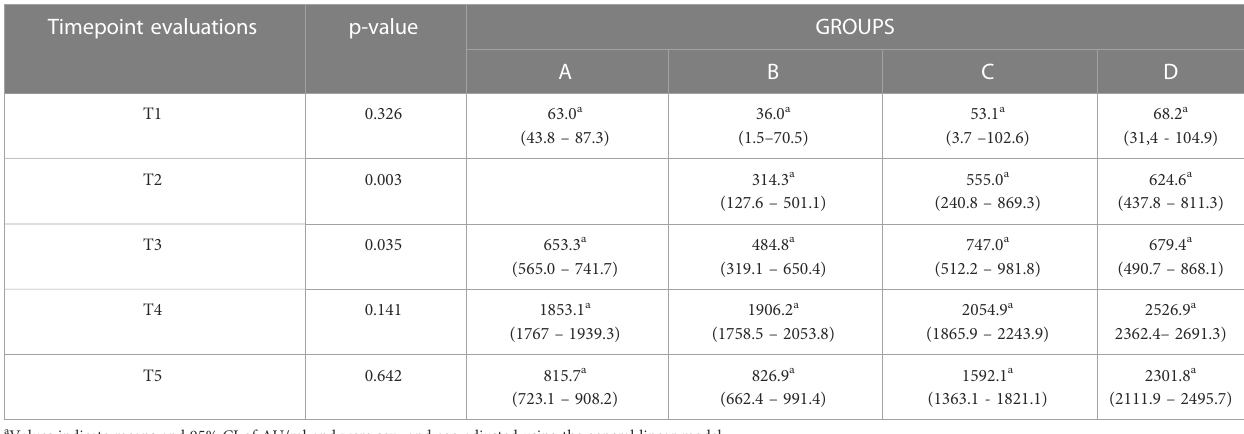
TABLE 3 Antibody levels at each time point evaluation according to the immunization protocols following the adjustment by the general linear model. Timepoint evaluations